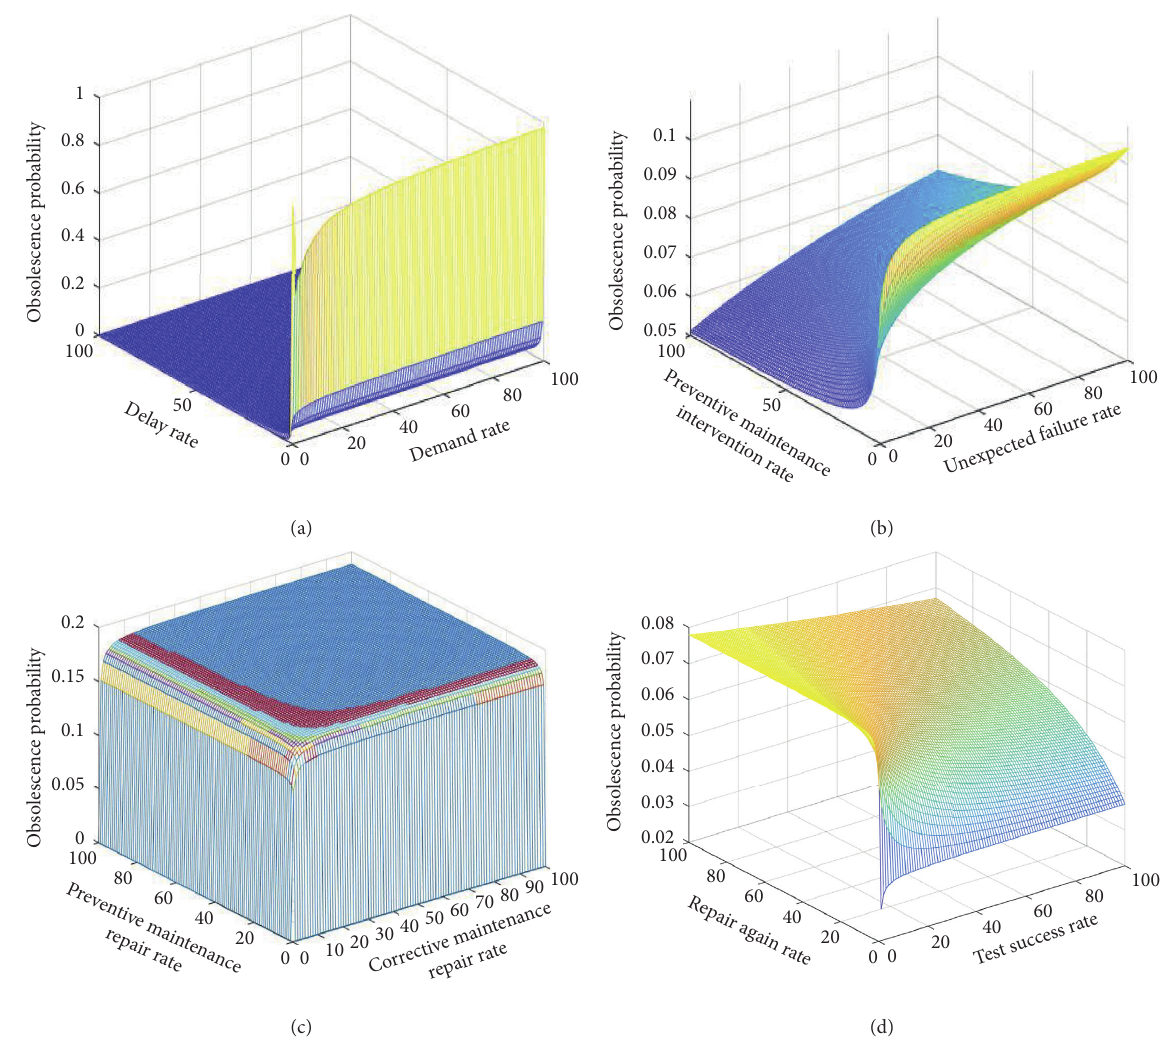
Figure 7: Obsolescence probability. (a) Variation of demand and delay rates. (b) Rate variation of unexpected failure and maintenance interventions. (c) Repair rate variation for corrective and preventive maintenance. (d) Test rate variation (repair again or